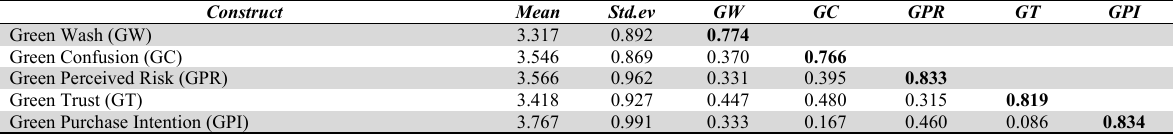
Descriptive Statistics and Discriminant Validity